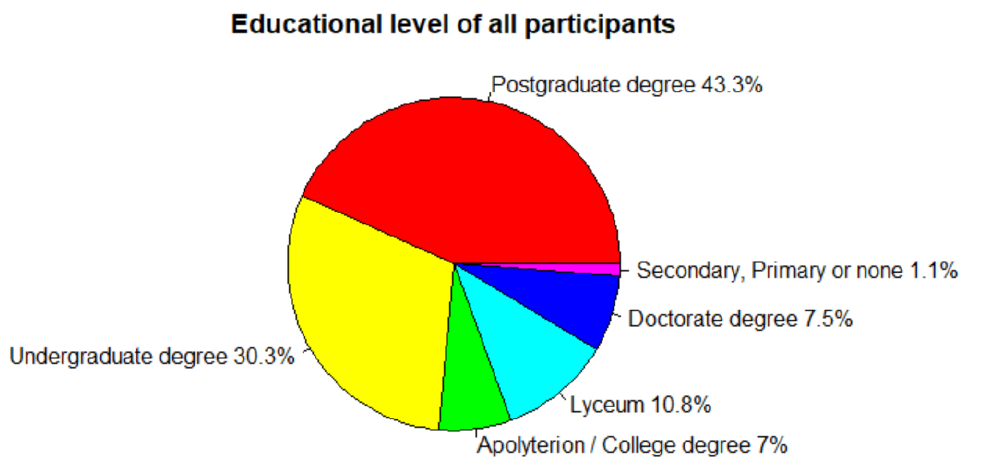
Figure 3. Study Area: Number of participants according to their educational level. Regarding the work sector most participants worked in the private sector (42.8%).